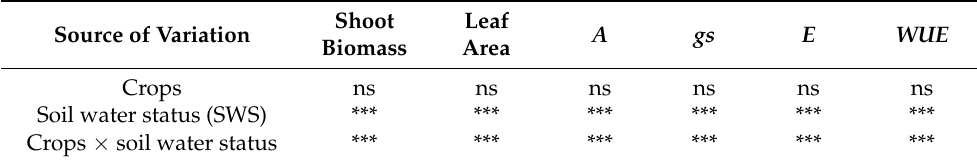
Table 1. The effect of the combination of environmental factors (soil moisture status and temperature) on shoot biomass, LA, A , gs , E , and WUE of crops (maize, sorghum, millet, and rice), and interaction between crops and environment in experiment 2. Source of